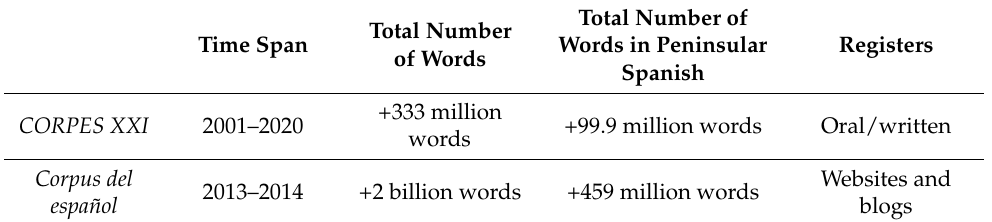
Table 1. General features of the CORPES XXI corpus (Real Academia Española 2021) and Davies’ (2016) Corpus del